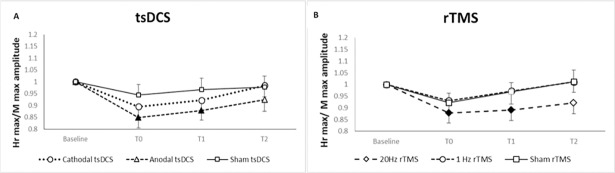
Induced effects of non-invasive stimulation combined with treadmill exercise in the monosynaptic reflex activity.A: Hr max/ Mmax amplitude ratio after trans-spinal direct current stimulation associated with treadmill. B: Hr max/ Mmax amplitude ratio after repetitive transcranial magnetic stimulation associated with treadmill. Shown are the mean ± SE of baseline-standardized Hr max /M max amplitude ratio before (baseline), immediately after (T0), 30 minutes (T30) and 60 minutes after experimental conditions (T60). Filled symbols indicate significant (p< 0.05) changes compared to baseline.